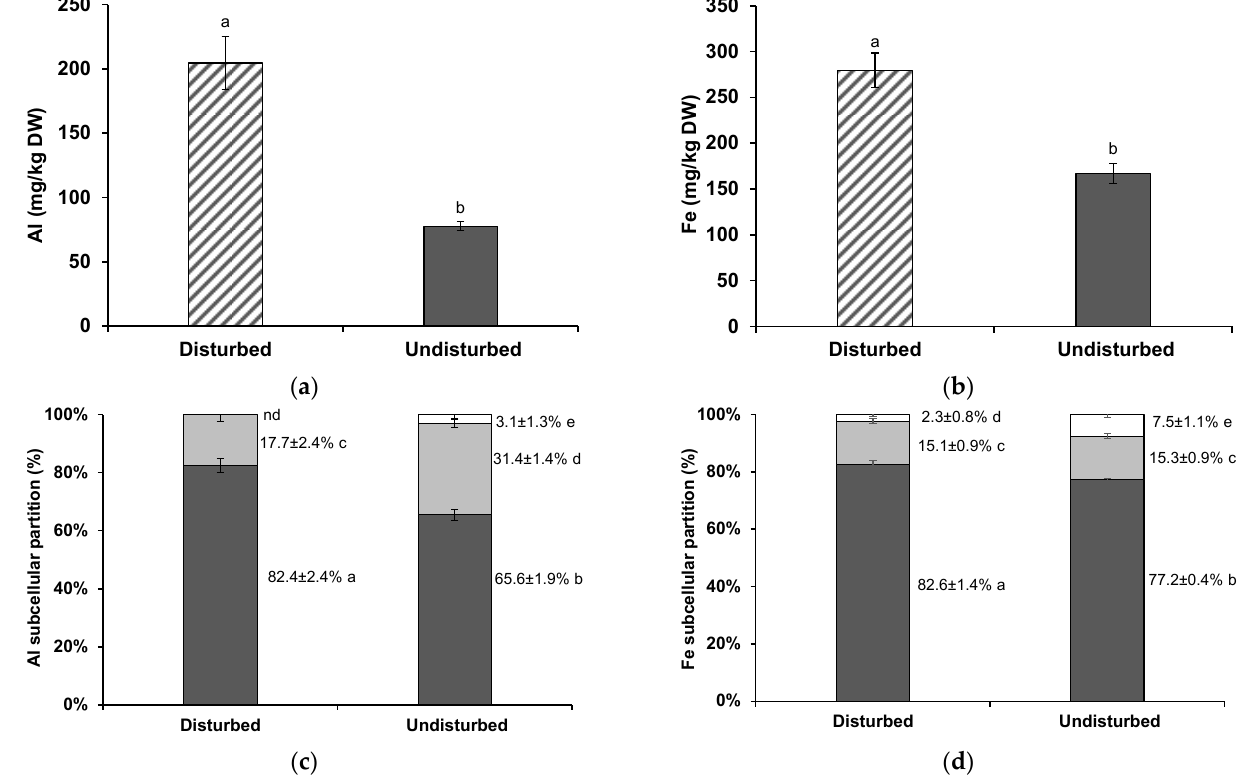
Figure 2. Concentration (average and standard error) of Al ( a ) and Fe ( b ) in the shoots of wheat plants grown in disturbed (striped columns) or undisturbed (grey columns) acidic soil, after Ornithopus compressus growth. The proportions (average and standard error) in the cell wall fraction (dark grey columns), organelle fraction (light grey columns), and vacuole contents fraction (white columns) were also determined for Al ( c ) and Fe ( d ). Values next to bars are the element percentages for each fraction. nd = Below detection limits. Different letters indicate statistically significant differences ( p <